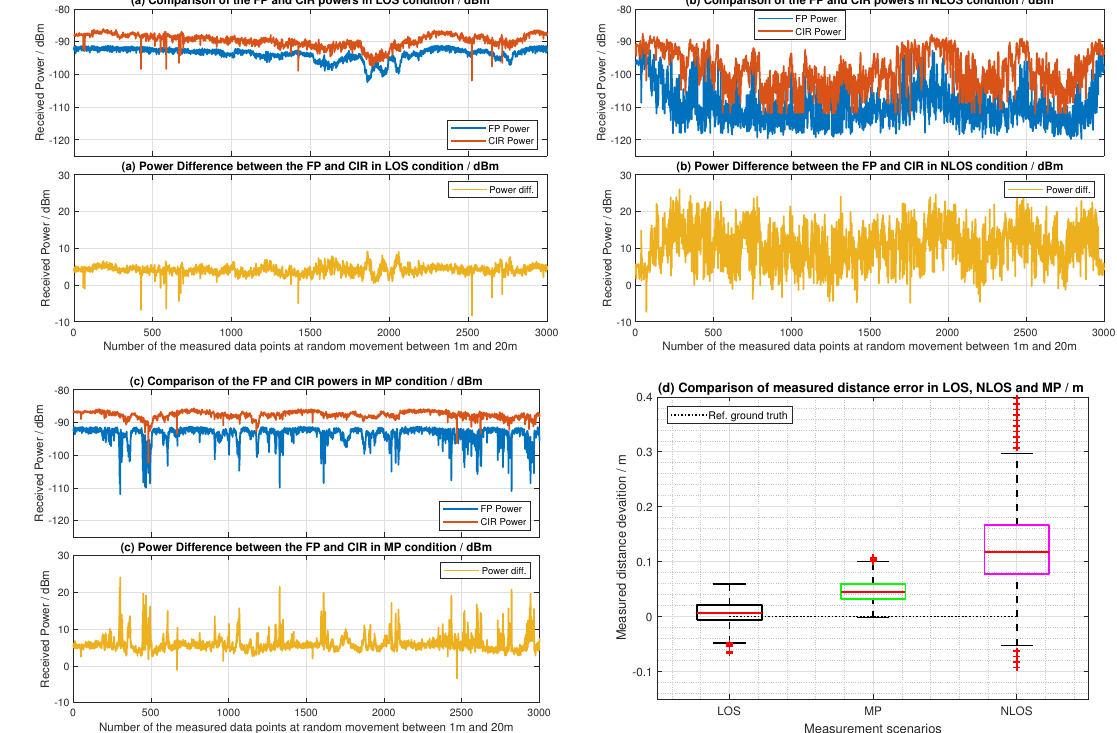
Number of the measured data points at random movement between 1m and 20m